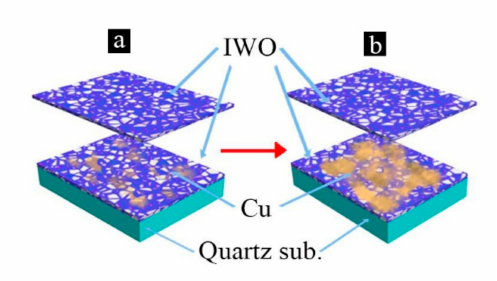
Figure 5. Schematic diagram of the evolution of the Cu layer in the IWO / Cu / IWO tri-layer films on quartz substrates. ( a ) Discontinuous Cu islands scatter on the IWO film. ( b ) Cu islands merge and form the semi-continuous porous